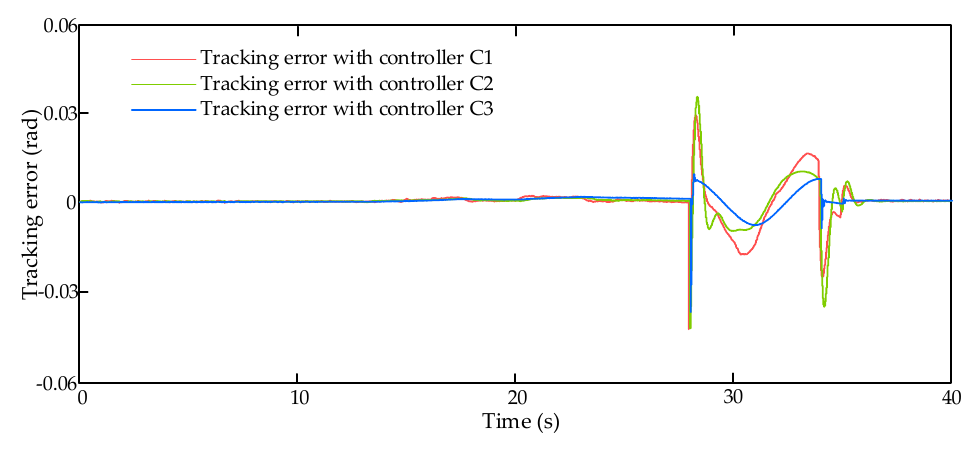
Figure 10. Tracking errors with real flight control command under random perturbance.